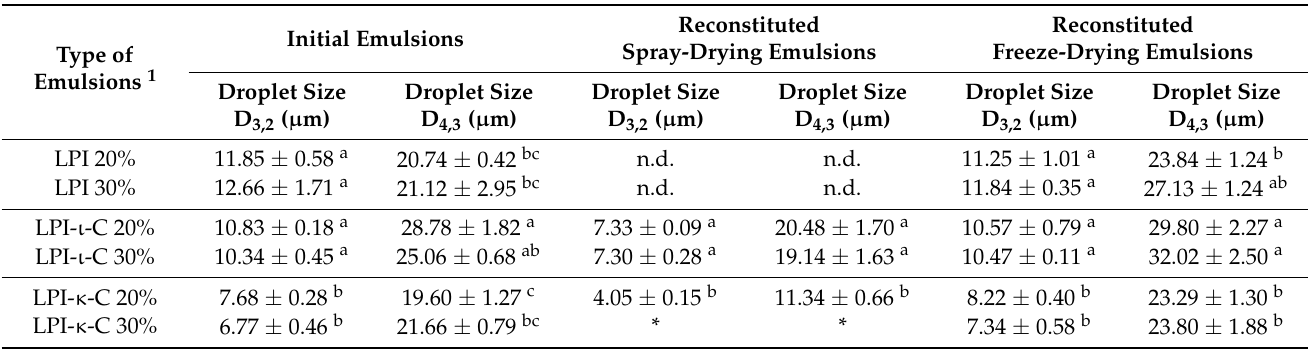
Table 2. Droplet size of initial emulsions and reconstituted emulsions. Data represents the mean ± one standard deviation ( n =